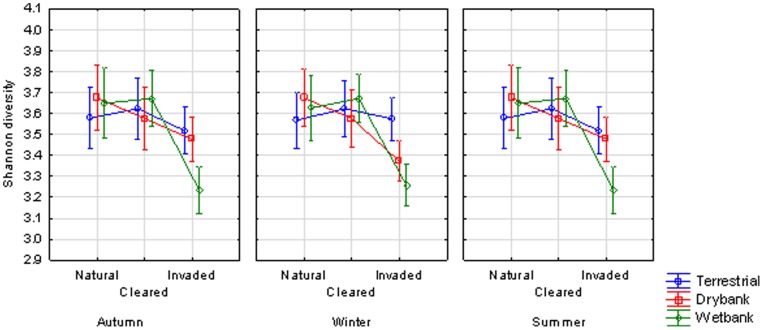
The Shannon’s diversity index based on the bacterial ARISA profiles comparing natural, cleared and invaded lateral zones for all three seasons.The interaction effect between hydrological zones and the invasive status was significant (F = 2.7191, p = .00580).